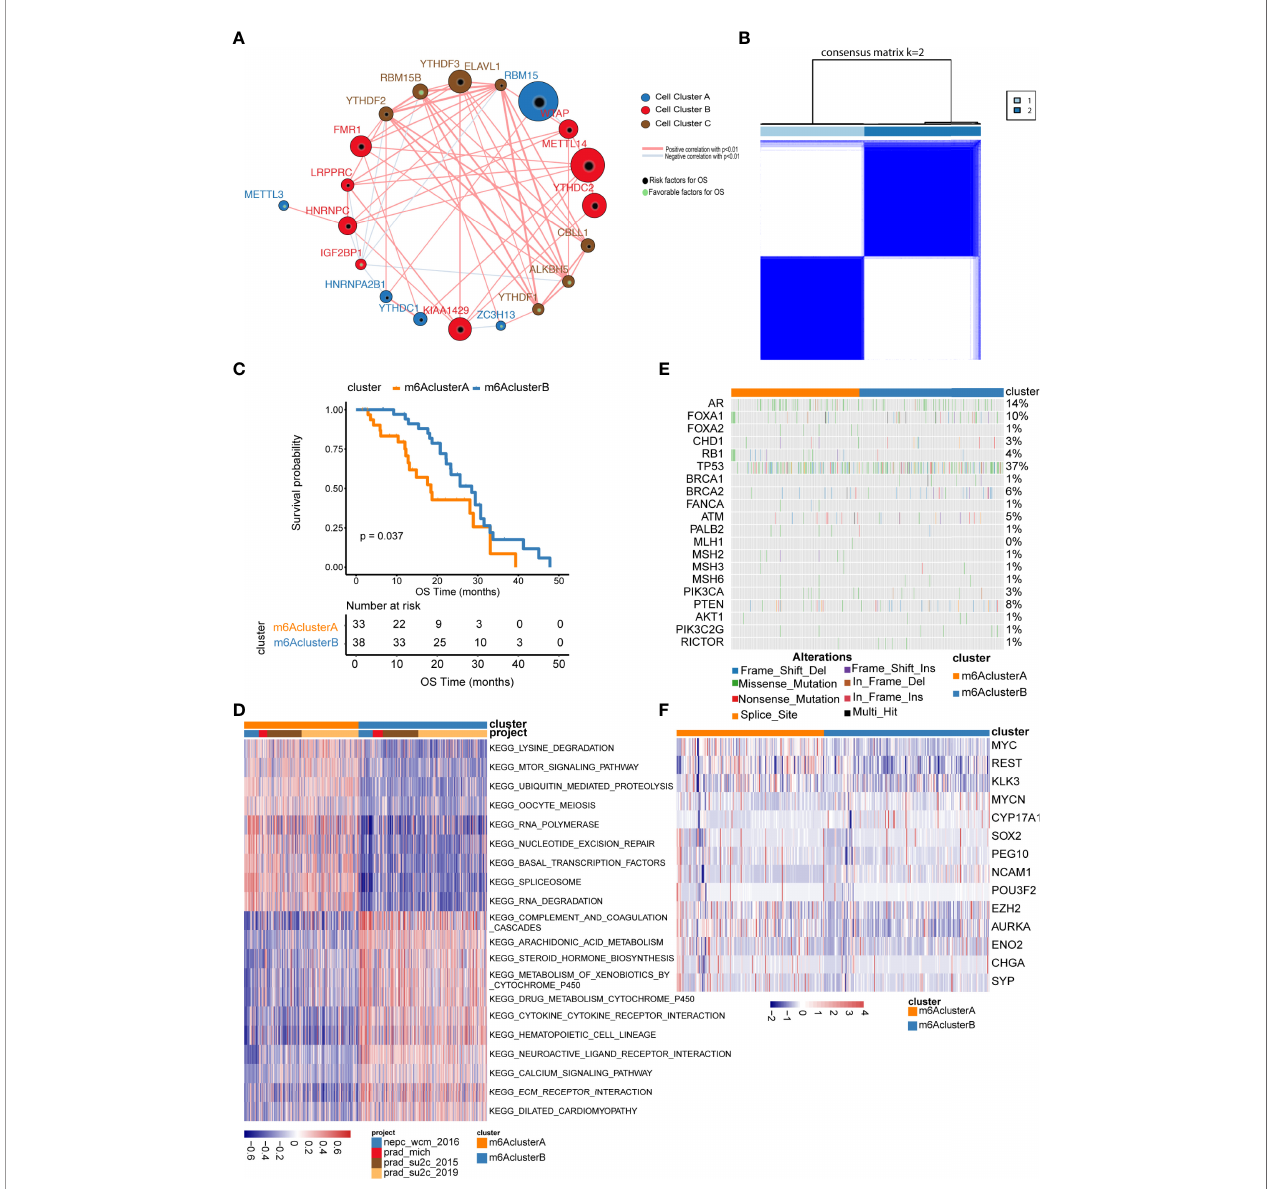
FIGURE 2 | Unsupervised clustering of m6A regulator genes in metastatic prostate cancer. (A) The interaction among m6A regulator genes. The size of circle indicates the effect of each gene on survival, the larger the size, the greater the effect is; green spots inside the circle indicate risk prognostic factors, black spots inside the circle indicate factors; lines that connect genes exhibit genetic interactions, red and blue represent positive and negative associations, respectively; gene Cluster A, B and C are shown as blue, red and brown, respectively; (B) Consensus clustering m6A regulator genes in metastatic samples; (C) Kaplan – Meier curves indicate that there is a strong relationship between the m6Acluster types and the overall survival rate; (D) GSVA enrichment analysis. Heatmaps show the activation status of biological pathways, which is displayed with different m6A clusters; red denotes activation, blue denotes inhibition; (E, F) show the distribution of the mutation and expression of partial genes in two m6A clusters,